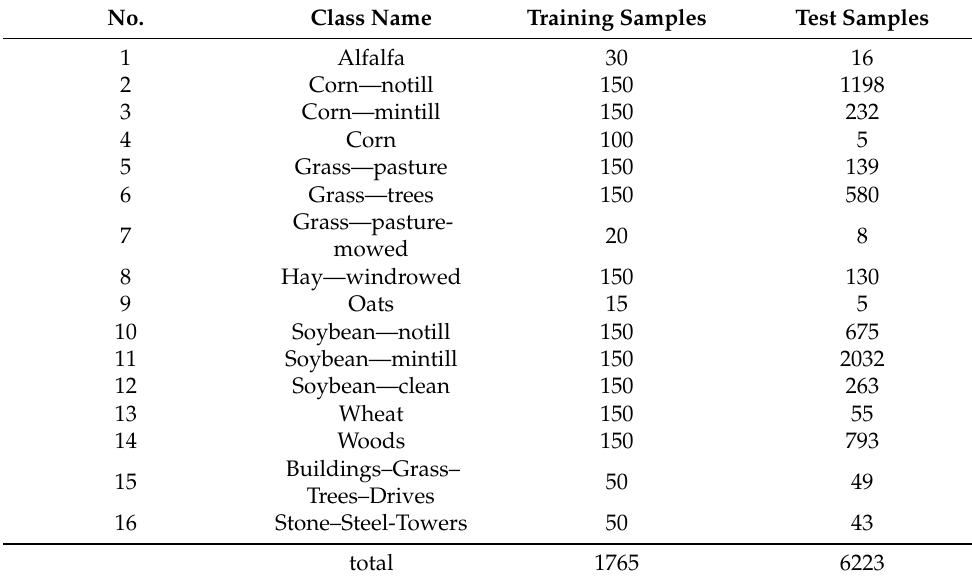
Table 2. Samples distribution for Indian Pines dataset.